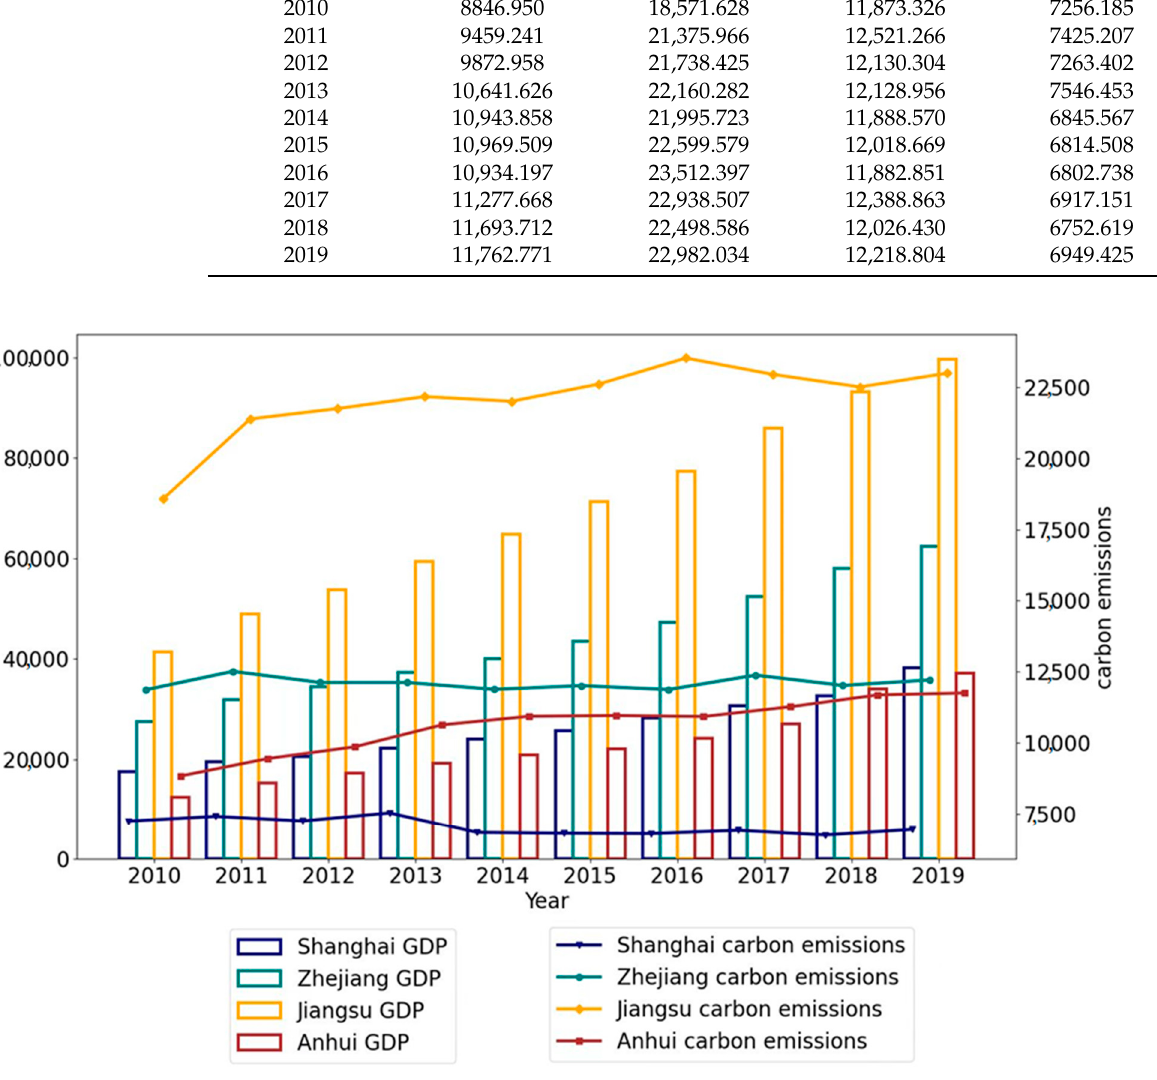
Figure 4. Carbon emissions and GDP for three provinces and one city in the YRD Region from 2010 to 2019.